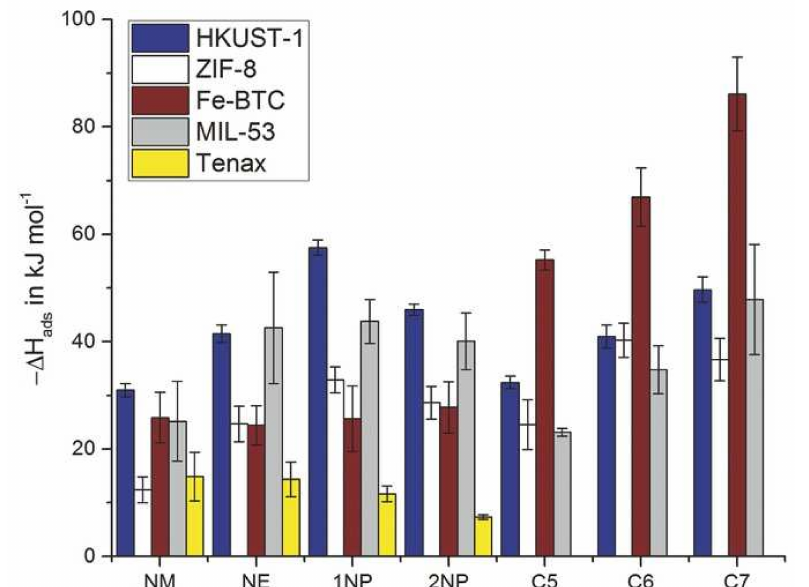
Figure 8. Enthalpies of adsorption for regular and nitroalkanes on all sorbents investigated in this study. Enthalpies in kJ mol − 1 . Analytes: nitromethane (NM), nitroethane (NE), 1- and 2-nitropropane (1NP and 2NP), as well as pentane (C5), hexane (C6), and heptane (C7). Reprinted with permission from [38]. Copyright (2018)